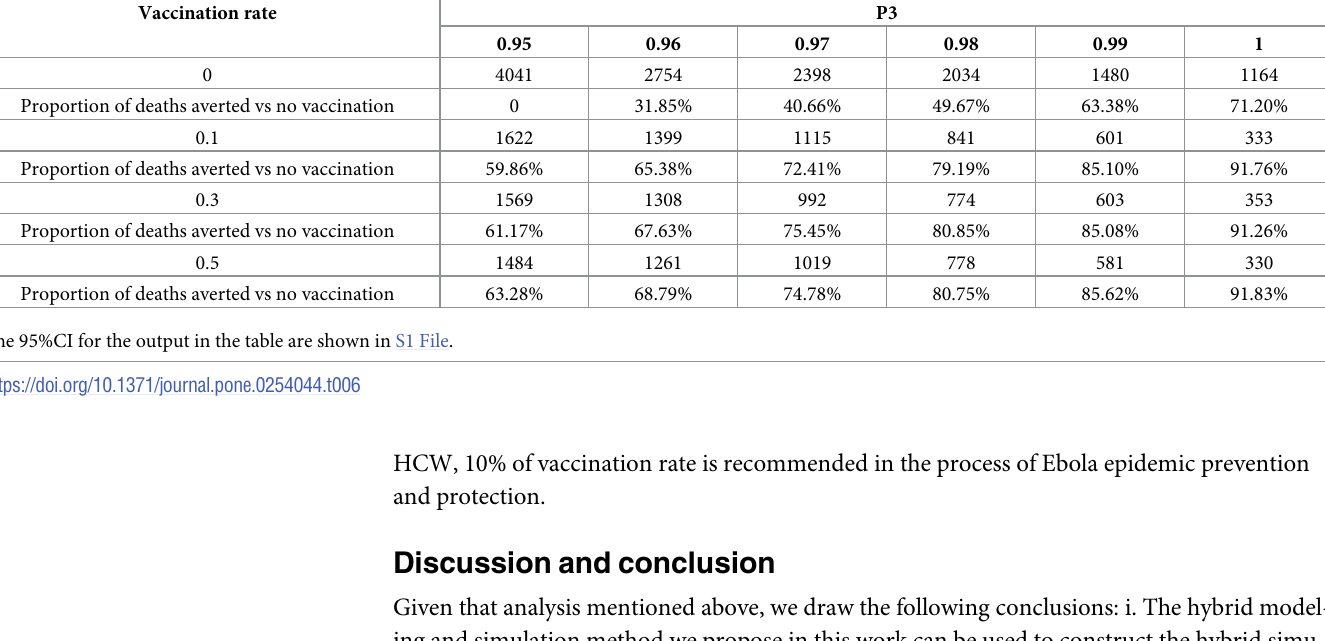
Table 6. Impact of combined interventions on cumulative Ebola deaths and the proportion of deaths averted versus no vaccination scenarios. Vaccination rate